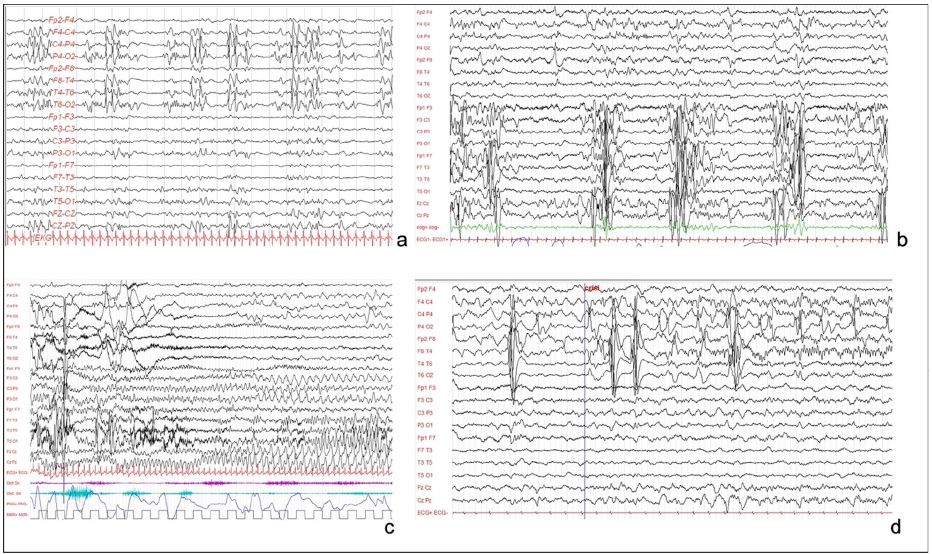
Figure 1. ( a ): MRI of patient 1, showing enlarged right hemisphere, with gray–white matter blurring mainly in the temporo-occipital regions. ( b ): T2-weighted sequence of patient 2 MRI, showing right enlargement of temporo-occipital regions, with blurring, extending also over the suprasylvian regions. ( c ): MRI of patient 3, showing enlarged and malformed cortex over the left hemisphere, mainly posteriorly. ( d ): MRI of patient 4, T2-weighted sequence, showing enlargement and malformation of left hemisphere, mainly temporal region.